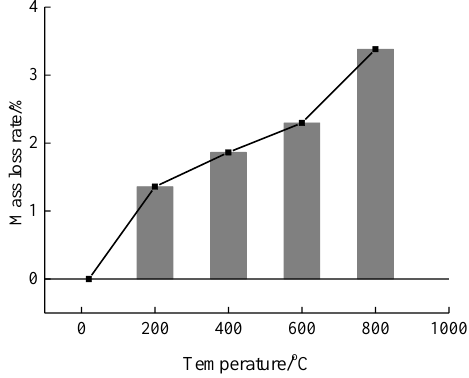
Figure 4. Temperature and concrete mass loss rate.